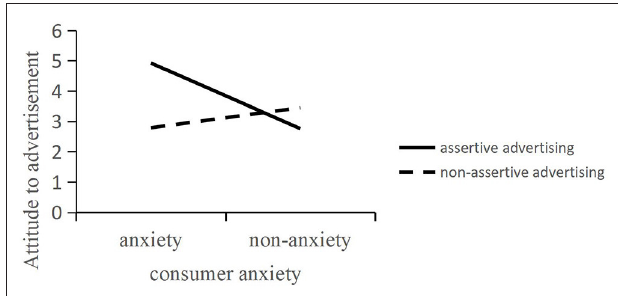
FIGURE 2 | The interaction between advertising types and consumer anxiety in Experiment 1.